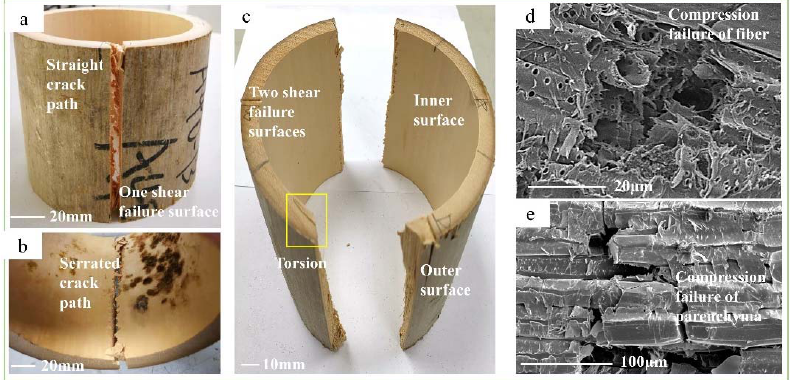
Figure 7. Shear-failure characteristics of cross-shear method: ( a ) failure specimen with one failure surface; ( b ) serrated crack path at inner surface; ( c ) failure specimen with two failure surfaces; ( d ) SEM image of the fiber fracture; ( e ) SEM image of the parenchyma-cell fracture.